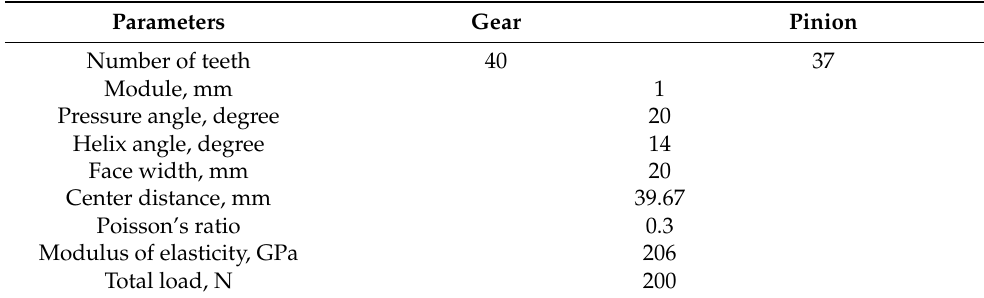
Table 4. Simulation parameters of helical